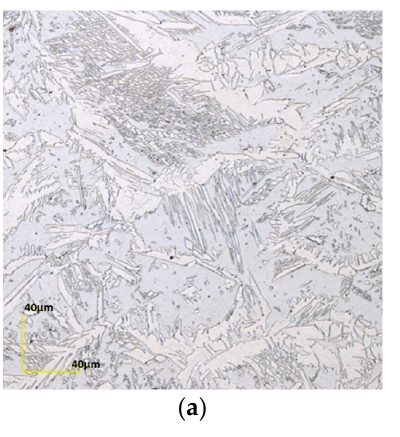
Figure 9. Microstructure observed in the HAZ of the sample subjected to postwelding solution heat treatment for 10 s at 1050 °C: ( a ) edge; ( b ) 1/4 region; ( c ) 1/2 region.